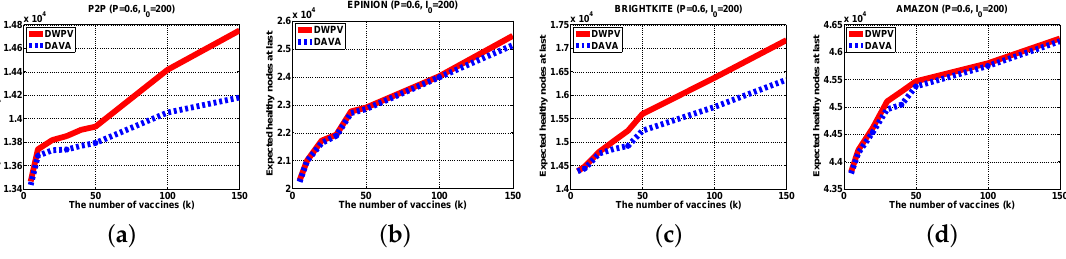
Figure 10. Experiments Results ( P = 0.6, I 0 = 200 ) . ( a ) P2P; ( b ) EPINION; ( c ) BRIGHTKITE; ( d ) AMAZON.